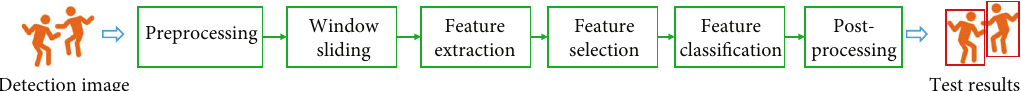
Figure 2: Schematic fl ow chart of the method of target detection and recognition based on image classi fi cation.